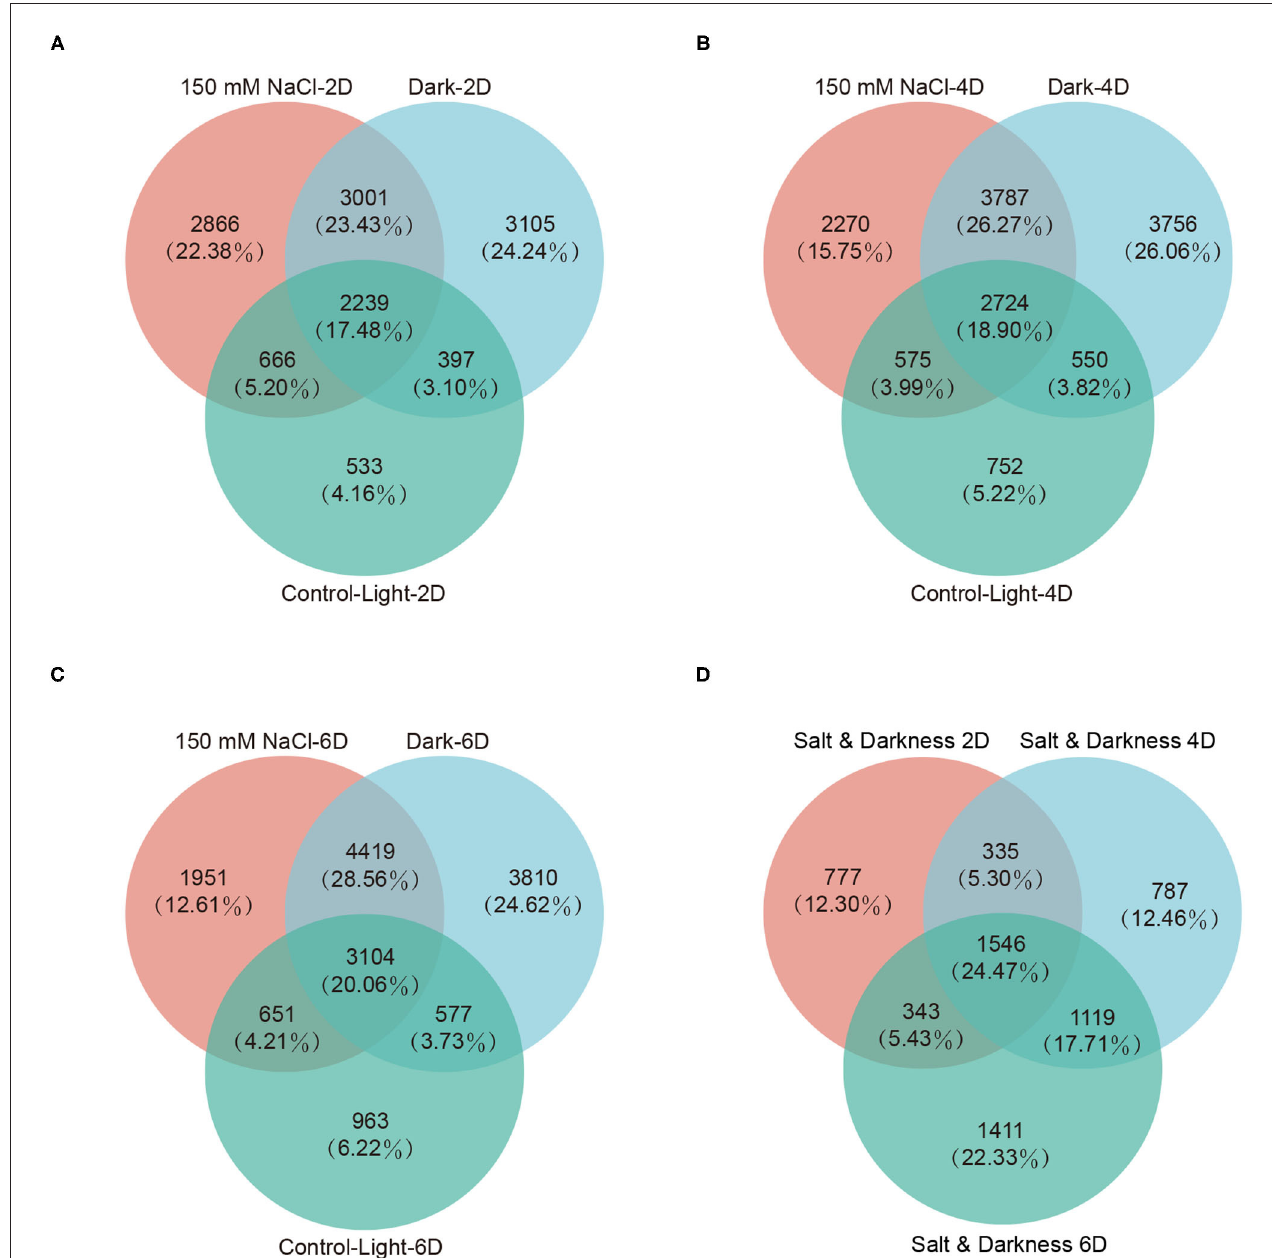
FIGURE 4 | Differentially expressed senescence-associated genes (SAGs) analysis. Differentially expressed SAGs in detached leaves under darkness and 150mM NaCl treatment on day 2 (A) , 4 (B) , and 6 (C) . (D) Venn diagram of SAGs shared by the darkness and 150mM NaCl treatments on day 2 ( A , 3001), 4 ( B , 3787), and 6 ( C , 4419). There were 1546 SAGs shared by darkness and 150mM NaCl treatments across three time points.